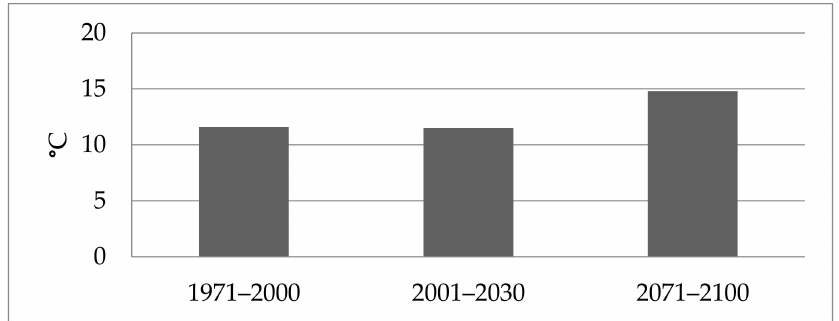
Figure 1. The mean air temperature in March, April, and May (MAM) over the baseline